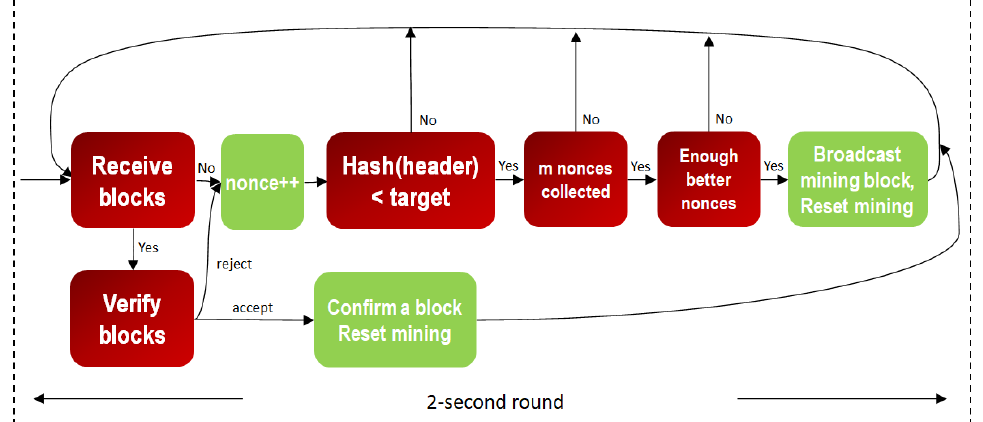
Figure 4. Mining flow of aggressive GPoW